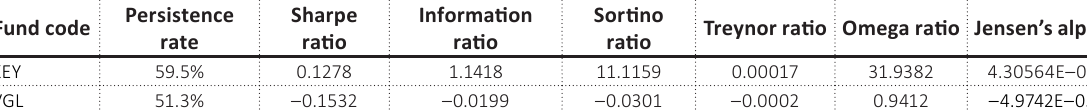
Table 11. Skill ratios of persistent pension